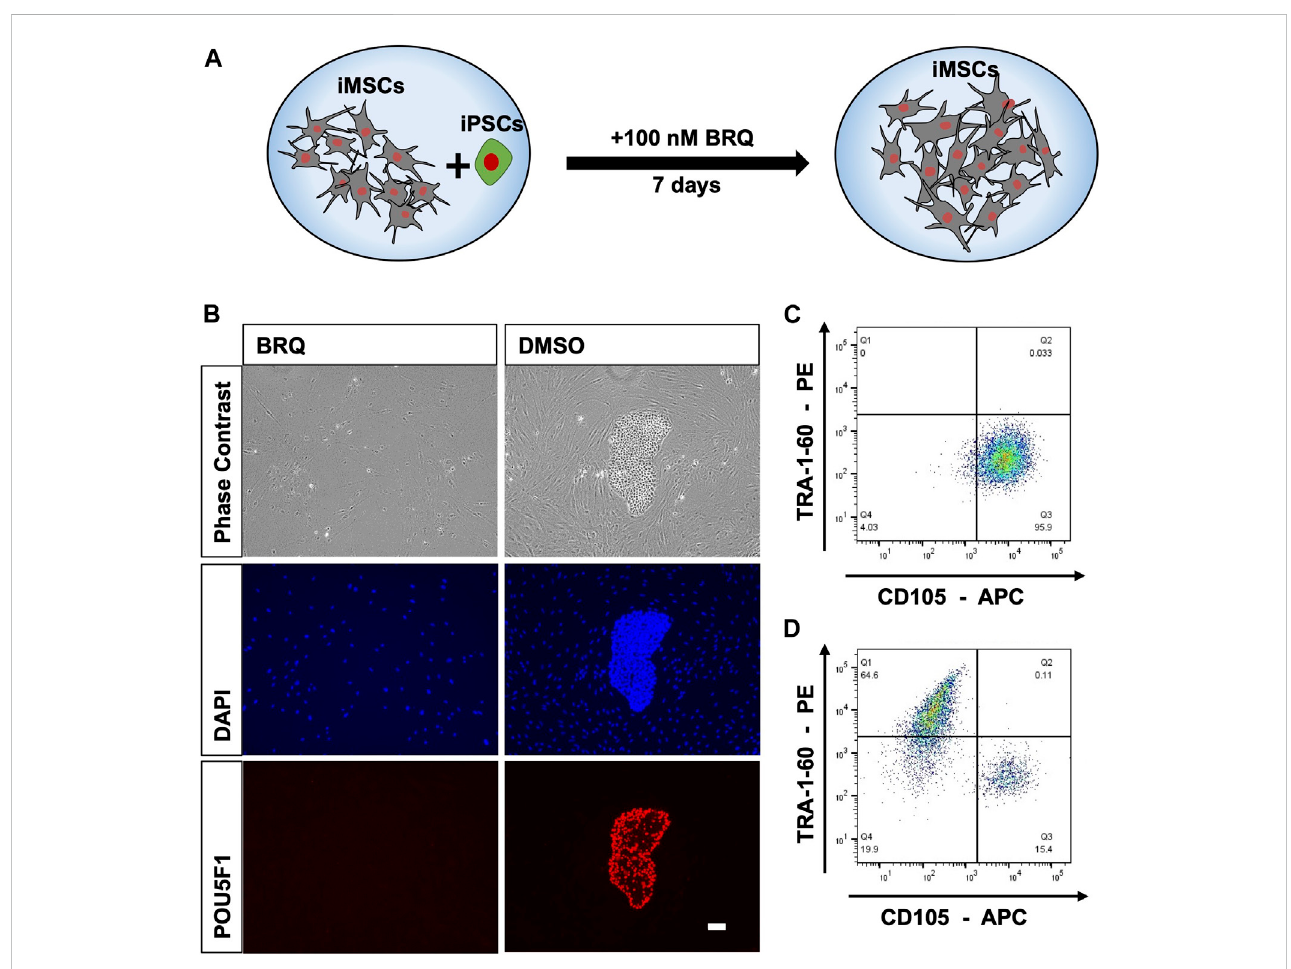
FIGURE 2 Selective elimination of hiPSCs by BRQ in iMSC-iPSC mixed culture. (A) Schematic representation of the mixed culture condition by mixing iMSCs with 10% hiPSCs and culturing both cell types in the presence of BRQ for 7 days. (B) iMSCs mixed with 10% hiPSCs cultured for 1 week in the presence of 100 nM BRQorDMSOcontrol.Cellswere fi xatedusing4%PFAthenimmunostainedusinganti-POU5F1(Red)antibodyandnuclearstainDAPI(Blue),scalebar100 µm. Mixed culture was repeated, (C) BRQ- and (D) DMSO-treated cells were stained with surface antibodies CD105 and TRA-1-60. Cells were then passed through the cell sorter for analysis. Experiments were performed in three biological repeats, representative fi